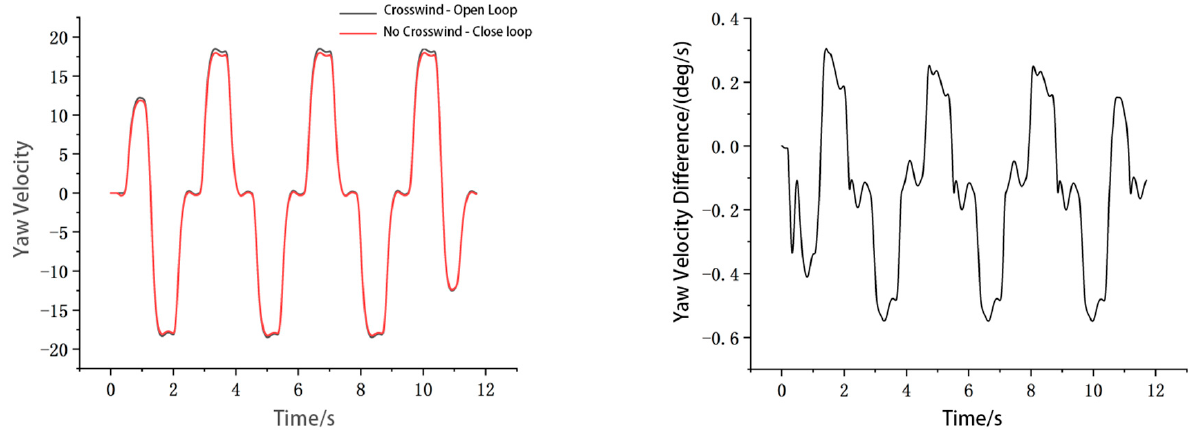
Figure 17. Comparison curves and difference curves of roll angle velocity with and without cross- wind effect.